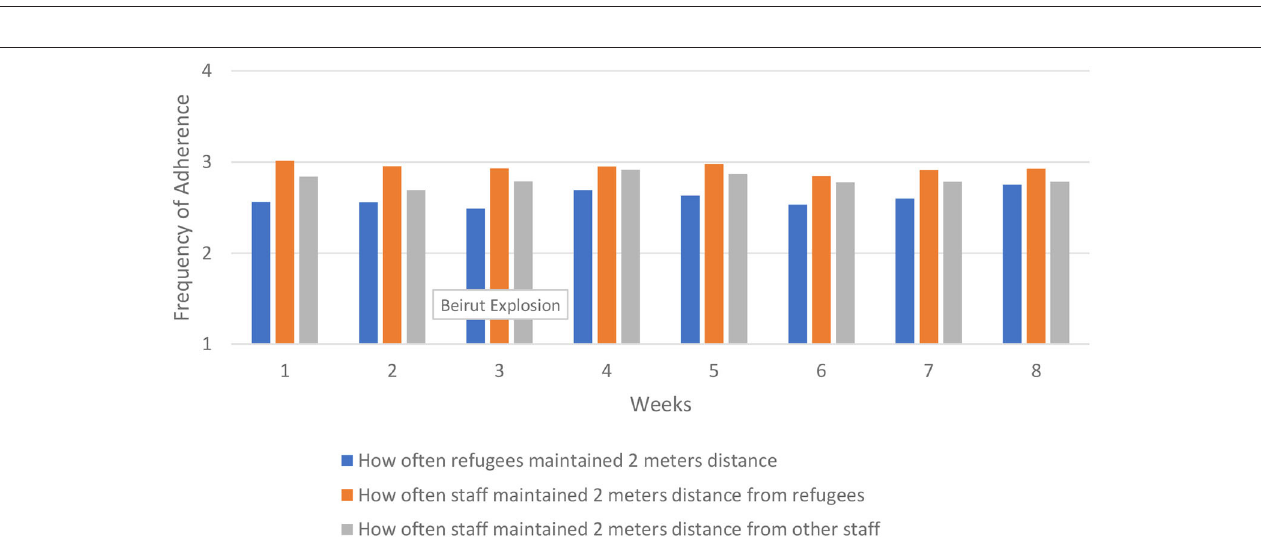
FIGURE 1 | Availability of soap and hand sanitizer by week and location.